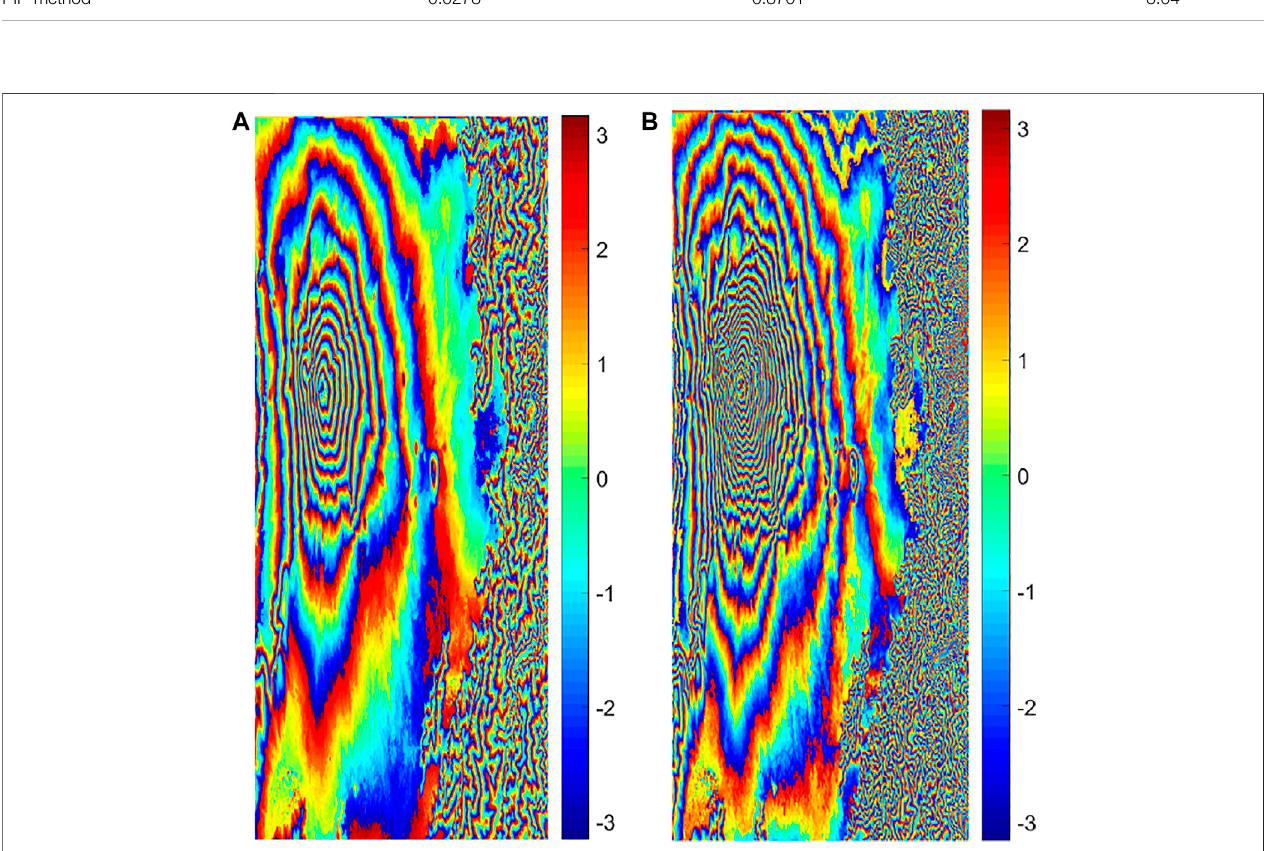
FIGURE 16 | Real Etna ERS-1/2 interferograms. (A) Short-baseline interferogram (rad). (B) Long-baseline interferogram (rad).